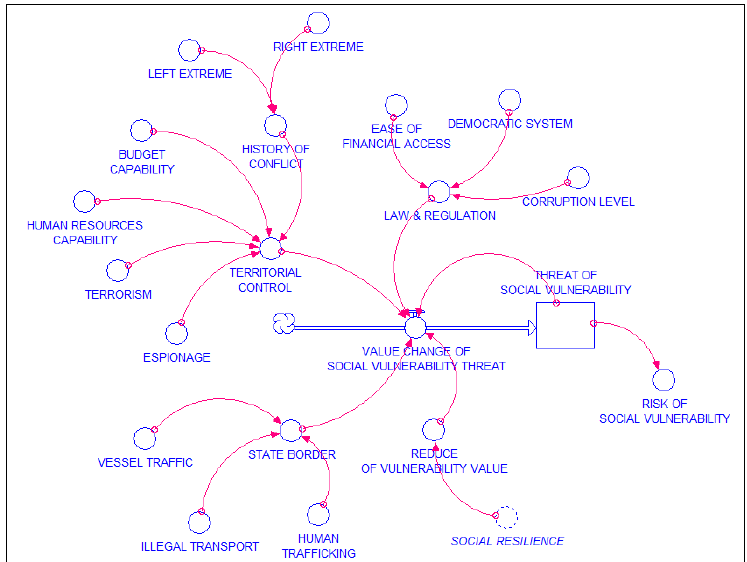
Fig. 6. Stock-flow diagram of the Influence of Islamic State (IS) Development on Social Vulnerability in Southeast Asia